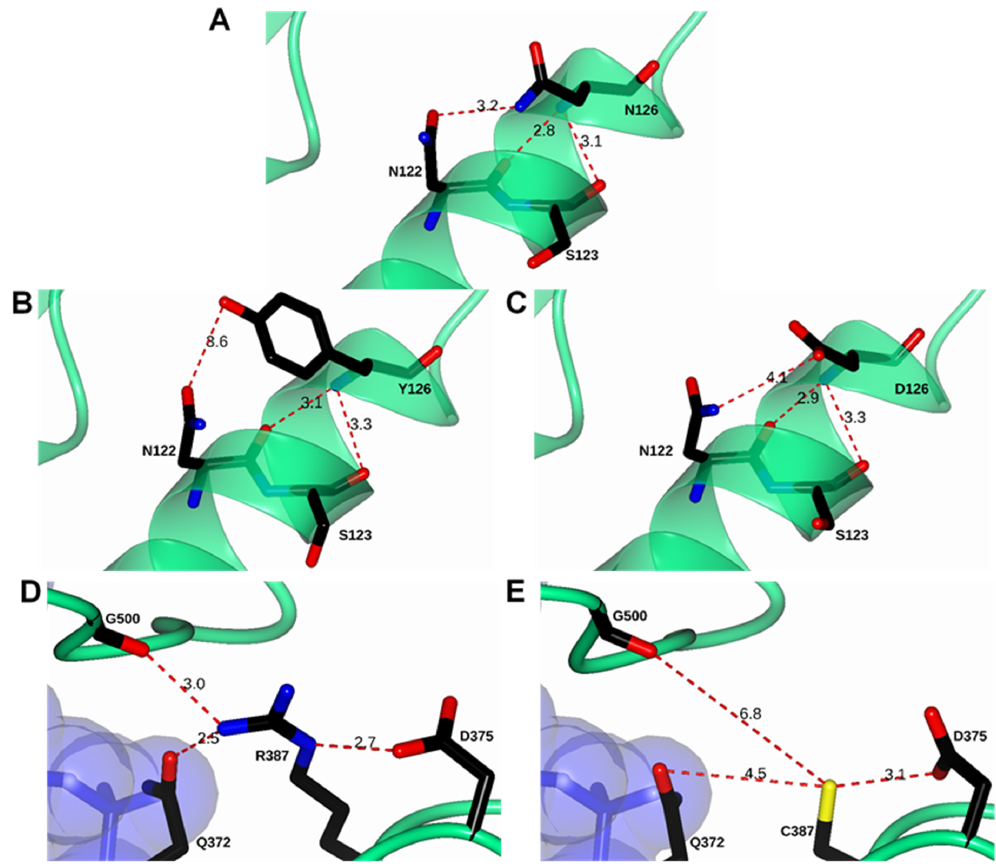
Figure 2. Structural comparison between human glucose-6-phosphate dehydrogenase (G6PD) enzyme (PDB entries 2BHL and 2BH9) and minimized models of Class I Guadalajara and Mount Sinai, Class II San Luis Potosi, and Class III A+. ( A ) Wild-type (WT) G6PD enzyme; ( B ) in silico N126Y mutation; ( C ) in silico N126D mutation; ( D ) WT G6PD enzyme; and ( E ) in silico R387C mutation. Note that double mutant R387C/N126D Mount Sinai is shown in (C) and (E). Residues are shown as black cylinders. Distances are in Å.